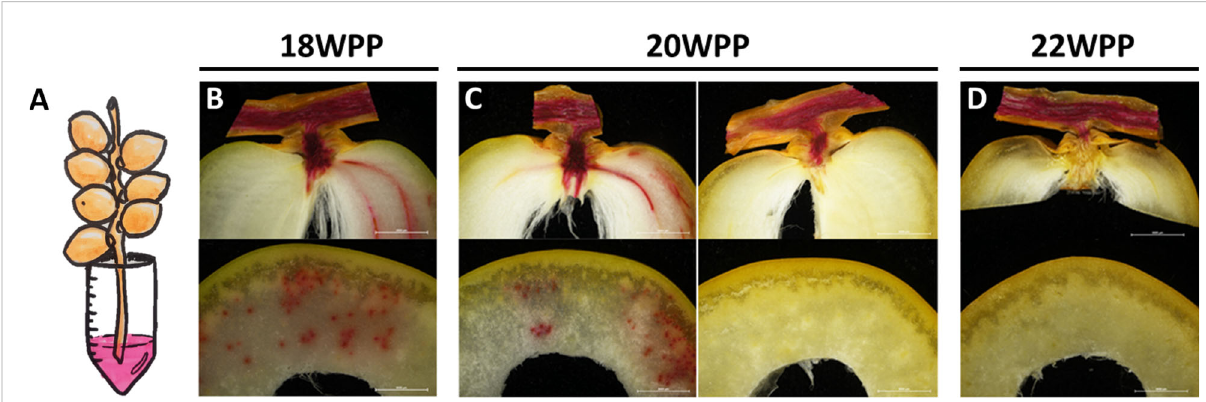
FIGURE 3 Vascular water fl ux arrest from the strand to the fruit occurs as part of date fruit development. Representative fruit-bearing strands were sampled along the course of fruit development (Gro fi t 2017) and movement of the dye Safranin O to the fruit was monitored (A) at different stages in fruit development